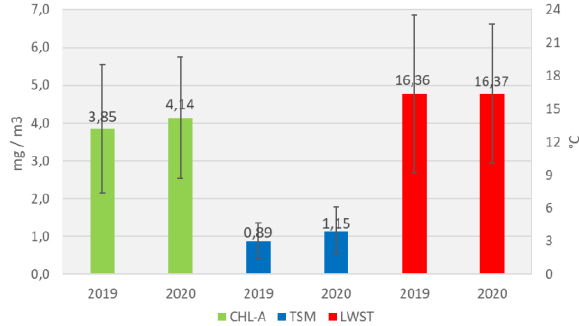
Figure 3 . Statistics for each WQP for each year under study.